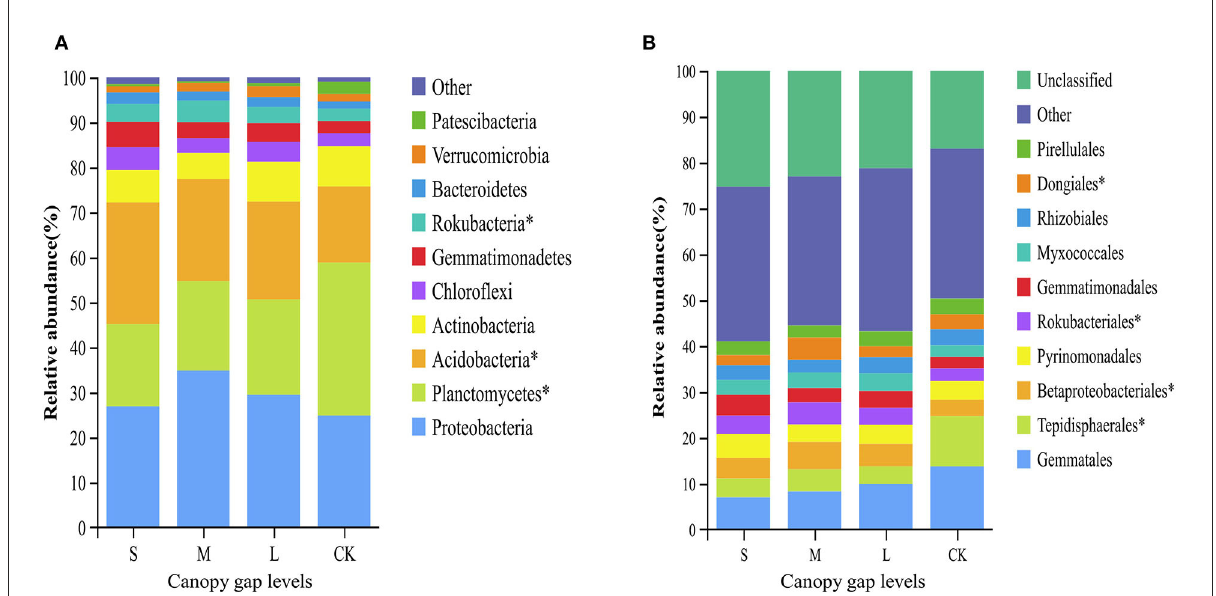
FIGURE3 Relative abundance of bacteria taxa at the phyla level (A) and the orders level (B) . Only the bacteria in the top ten relative abundance are shown. A single asterisk indicates p < 0.05. “S” stands for small gaps; “M” stands for medium gaps; and “L” stands for large gaps.